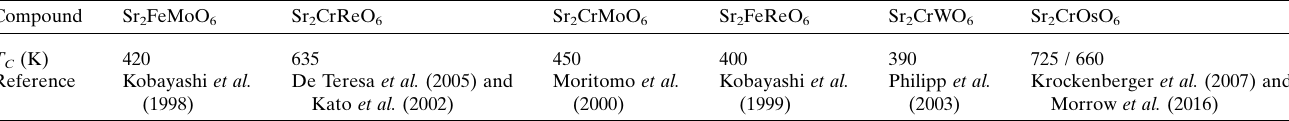
Table 1 Typical half-metallic and ferrimagnetic double perovskites.